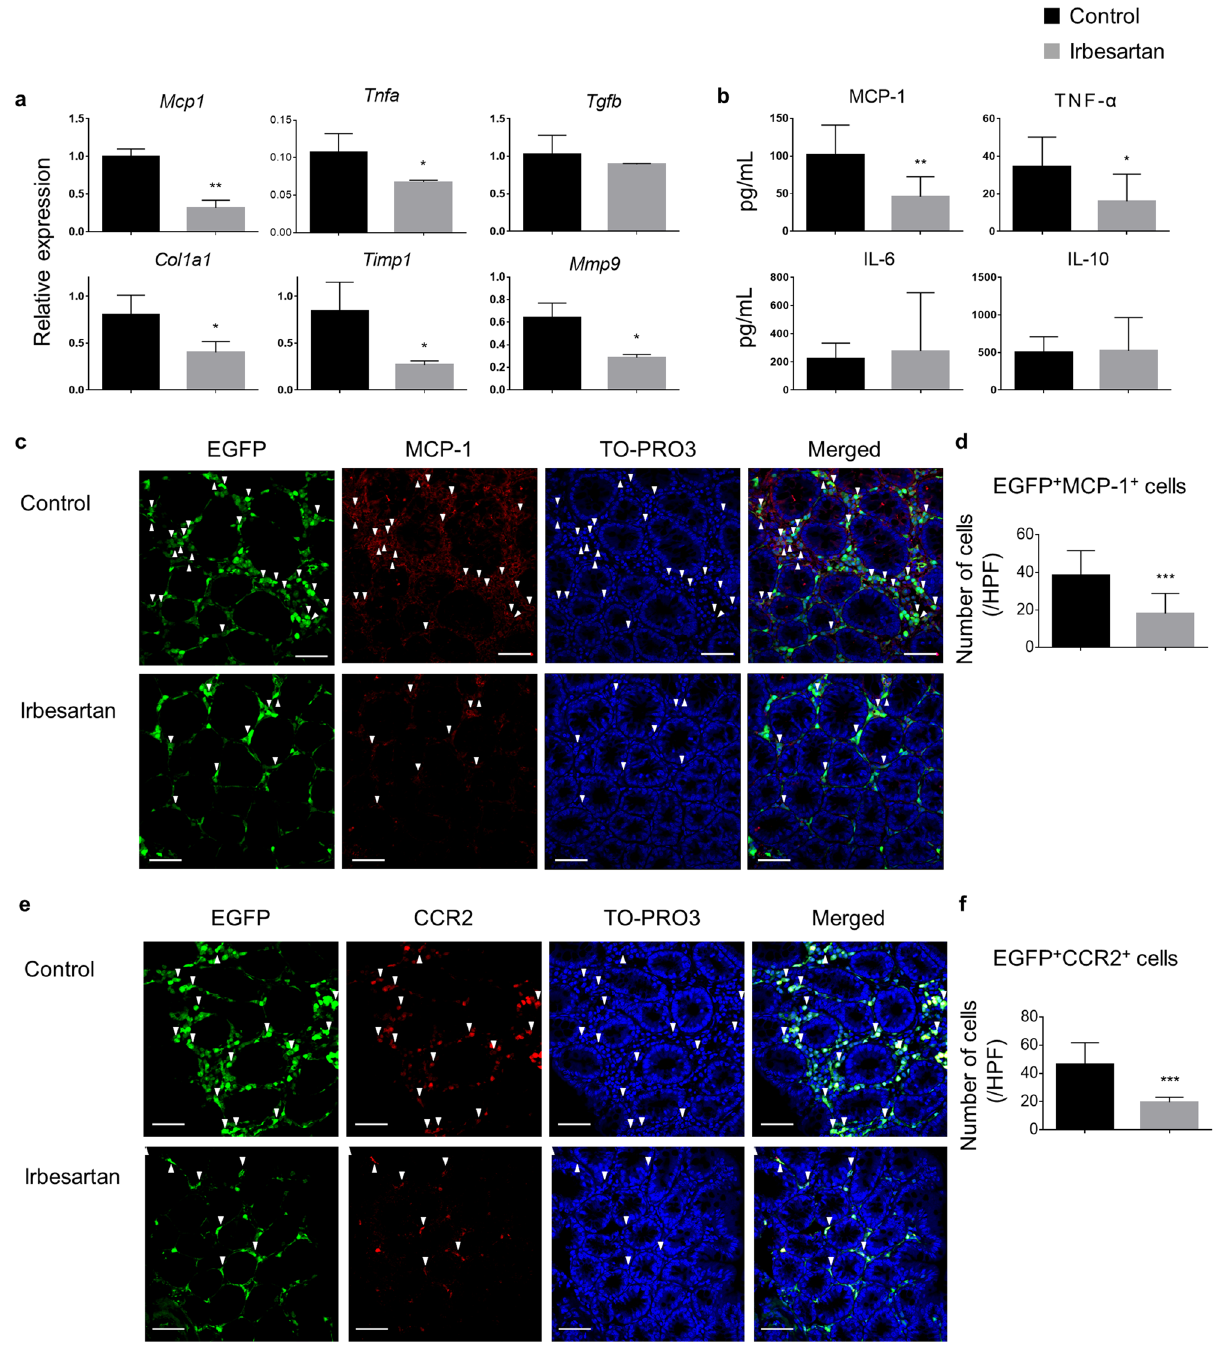
Figure 4. Inhibition of monocyte chemoattractant protein-1 (MCP-1) production in the inflamed colon by irbesartan. ( a ) The histograms show mRNA expression levels relative to that of Gapdh of Mcp1 , Tnfa , Tgfb , Col1a1 , Timp1 and Mmp9 in colon tissues obtained from control (n = 4) and irbesartan-treated mice (n = 4). The experiments were performed three times and yielded similar results. ( b ) Multiplex assay of chemokine and cytokine plasma concentrations in control and irbesartan-treated mice (n = 8 per group, pooled from two independent experiments). ( c ) Frozen colon sections obtained from control (n = 3) and irbesartan-treated mice (n = 3) 10 weeks after AOM injection. The panels show EGFP in green, MCP-1 in red and TO-PRO3 in blue. White triangles indicate EGFP + MCP-1 + cells. Scale bars, 50 μm. ( d ) The histograms show the number of EGFP + MCP-1 + cells in the colon of control and irbesartan-treated mice. ( e ) Frozen colon sections from control and irbesartan-treated mice 10 weeks after AOM injection. The panels show EGFP in green, CCR2 in red and TO-PRO3 in blue. White triangles indicate EGFP + CCR2 + cells. Scale bars, 50 μm. ( f ) The histograms show the number of EGFP + CCR2 + cells in the colon of control and irbesartan-treated mice. The experiments were performed twice and yielded similar results. Data are presented as mean ± SD. *P < 0.05; **P < 0.01 and ***P < 0.001 versus control